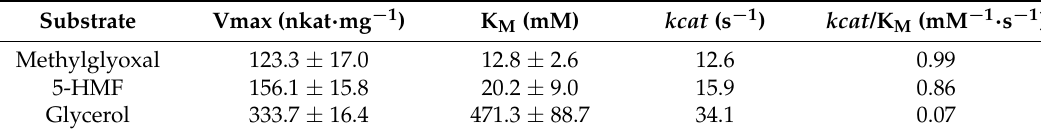
Table 2. Kinetic parameters of Mt GLOx with different substrates.